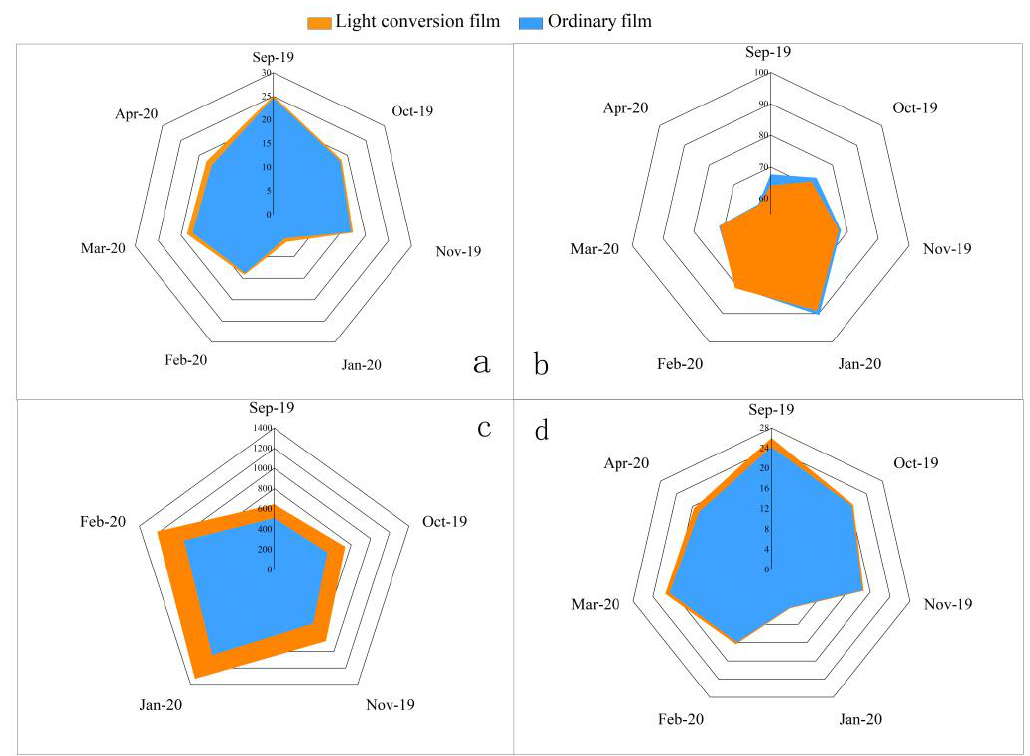
Figure 10. Synergistic effects of light conversion film (LCF) and ordinary film (OF) on ( a ) air tem- perature, ( b ) air humidity, ( c ) CO 2 concentration, and ( d ) soil temperature.